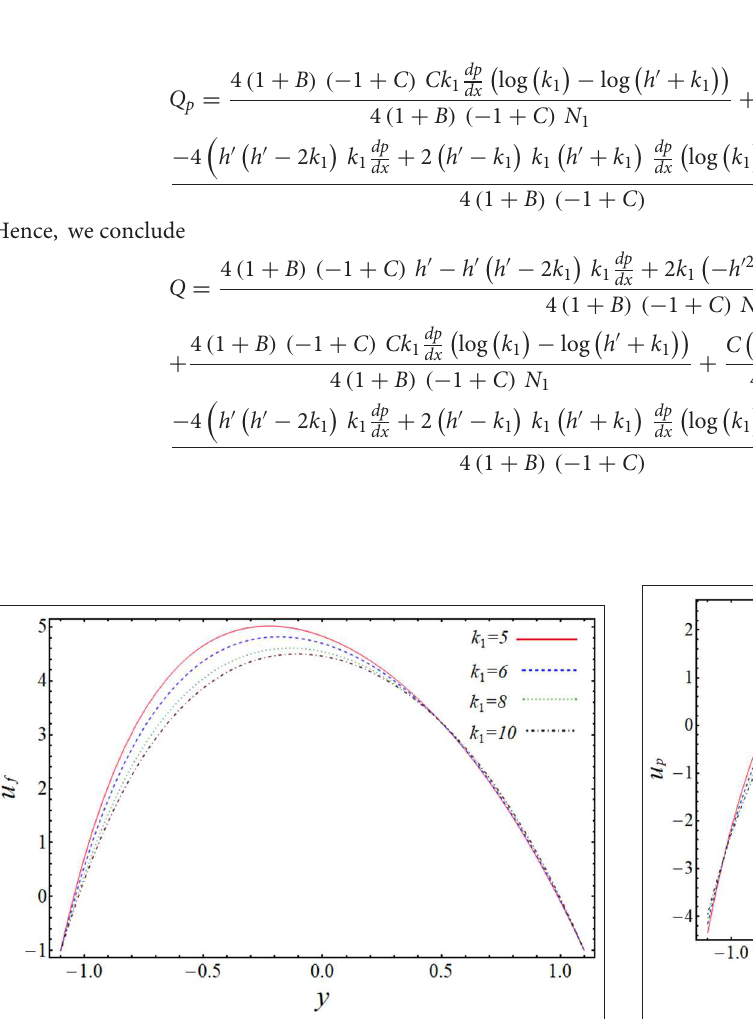
FIGURE 2 | Change of velocity u f for k 1 when Q = 1, x = 1, φ = 0.1, N 1 = 0.9, B = 0.02, A = 0.01, C = 0.12.